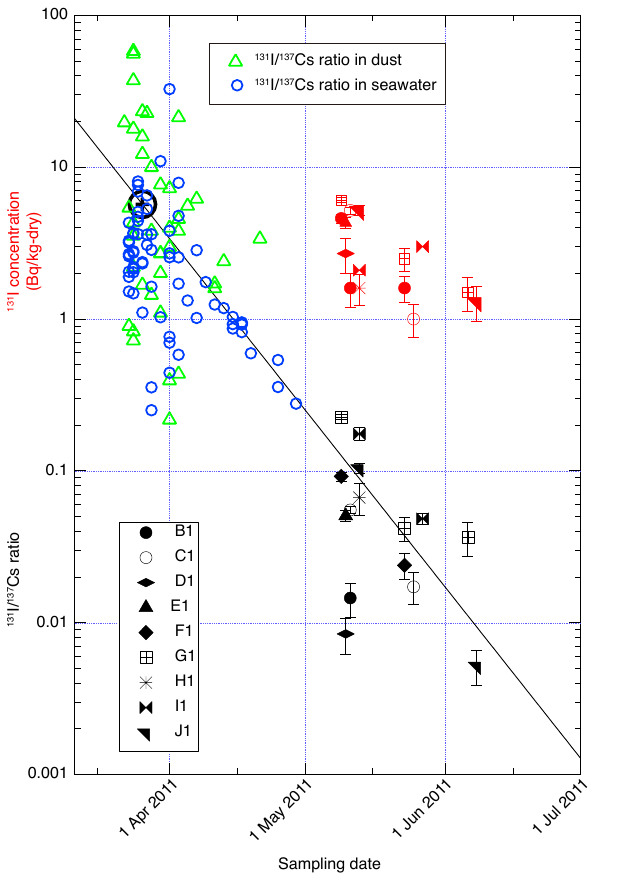
Fig. 11. Temporal variations of 131 I concentration and 131 I/ 137 Cs ratios in airborne dust, seawater, and sediments. The line shows the decay curve of the 131 I/ 137 Cs ratio based on an estimated initial ratio of 5.7 on 26 March 2011 (indicated by the circled cross; see Sect. 3.5 and Tsumune et al., 2012). 131 I/ 137 Cs ratios in dust and seawater were derived from data reported by MEXT (2012) and Oikawa et al. (2013, respectively).